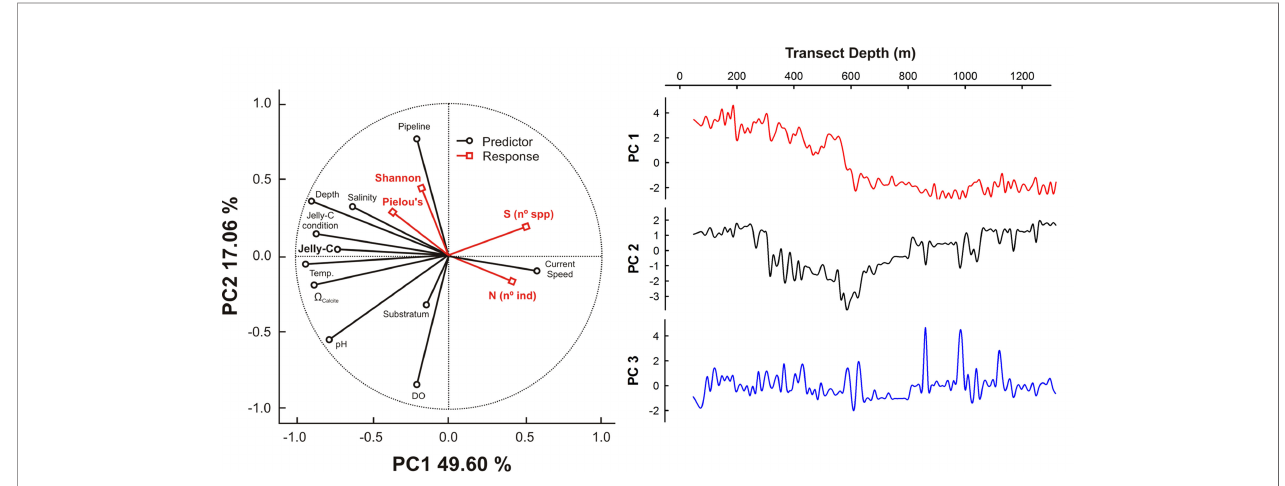
FIGURE 6 | Principal component analysis (PCA) describing ecological and environmental patterns. PC axis 1 and PC axis 2 percentages are presented in the circular plot. PC axis 1 and PC axis 3 results also were plotted against transect depth to facilitate analysis of bathymetric-based